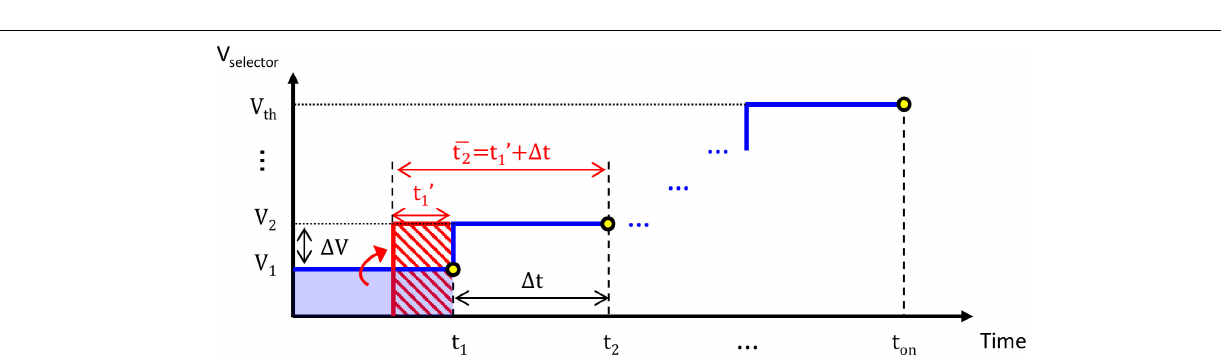
Frontiers in Neuroscience |